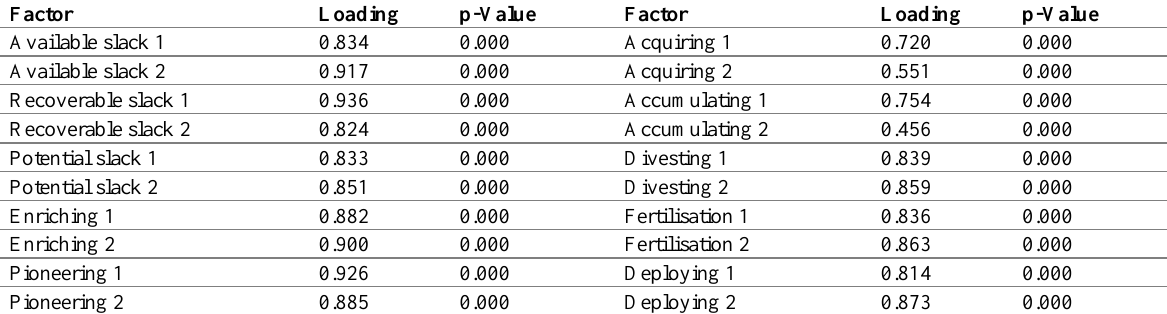
Table 2: Confirmatory Factor Loadings for Resource